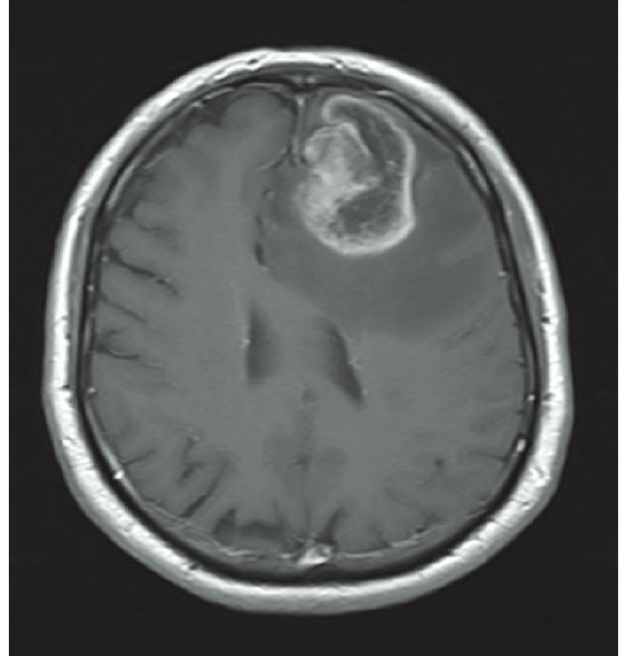
Fig. 1b. FLAIR axial view shows surrounding oedema and associated pressure